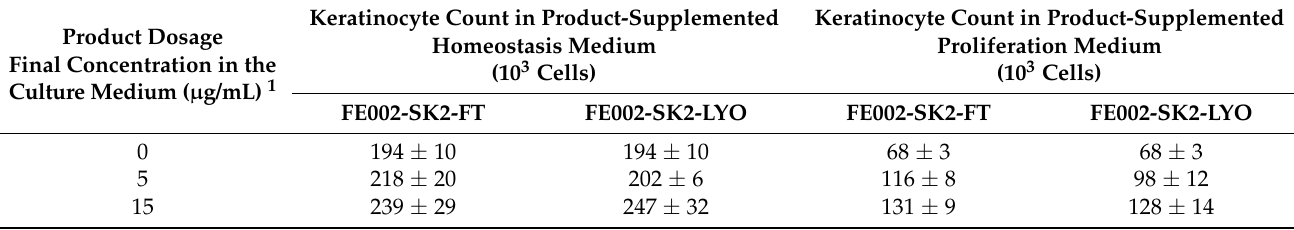
Table 3. Quantitative results of primary keratinocyte proliferation stimulation by dermal FPC lysates and lyophilizates in homeostasis medium or in proliferation medium, respectively, for each group. In all individual settings, a significant and dose-dependent promotion of keratinocyte proliferation was obtained by the addition of the treatment, as compared to the control wells. When considering each medium separately, no statistically significant difference was found between the ability of cell lysates and the ability of cell lyophilizates to promote keratinocyte proliferation. Cell lysates were obtained by freeze-thaw (FT) cycles and lyophilizates were obtained using formula B for stabilization processing. Values are presented as average cell counts after harvest, with corresponding standard deviations. FPC, fibroblast progenitor cells; FT, freeze-thaw; LYO,